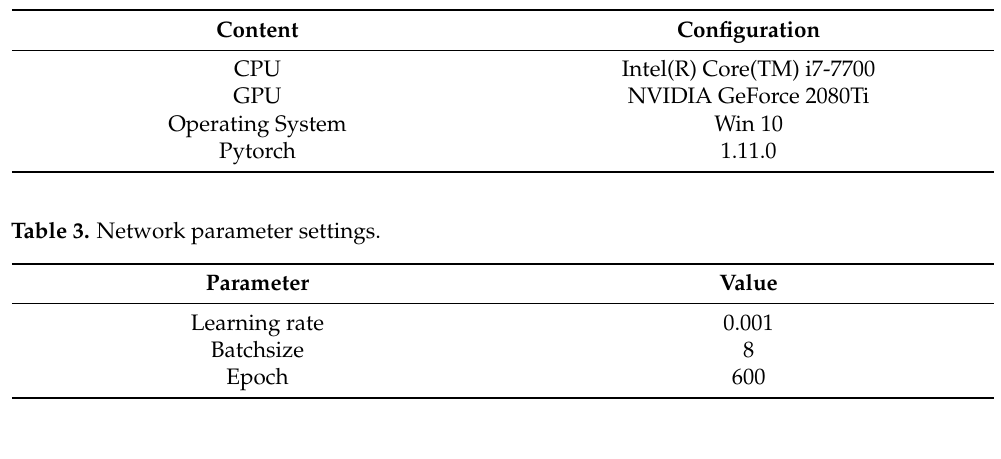
Table 2. Experimental environment and configuration.